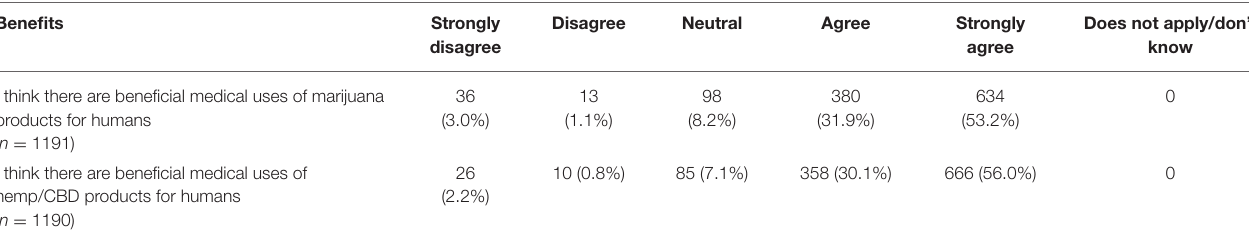
TABLE 11 | Participants’ views regarding the potential medical benefits of hemp/CBD/marijuana for humans. Benefits Strongly